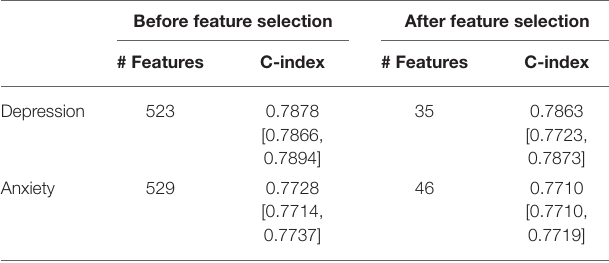
TABLE 2 | Summary of the best-performing DeepSurv models for depression and